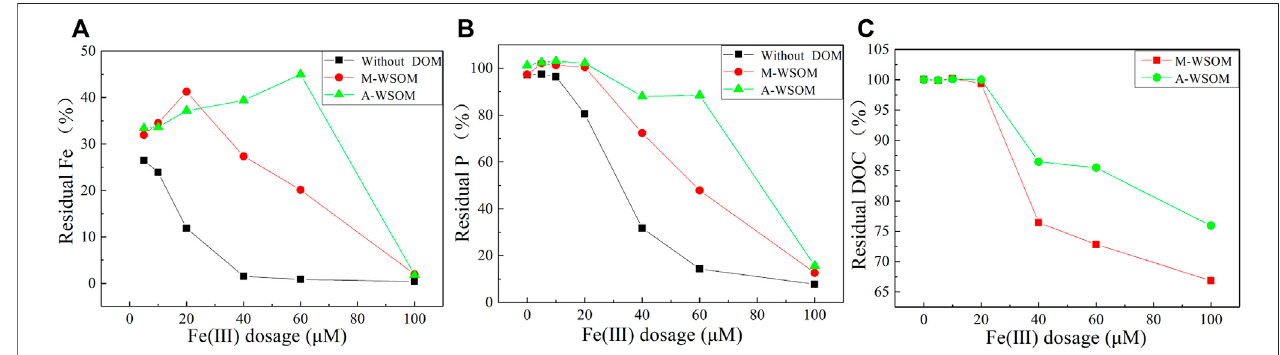
FIGURE4| Residualpercentage ofFe(III) (A) ,PO 43 − (B) ,andDOC (C) aftercoprecipitation ofWSOM-Fe-P insedimentsfromMeiliangBay, EastTaihuLake(pH = 6.5, DOC = 6 mg/L).